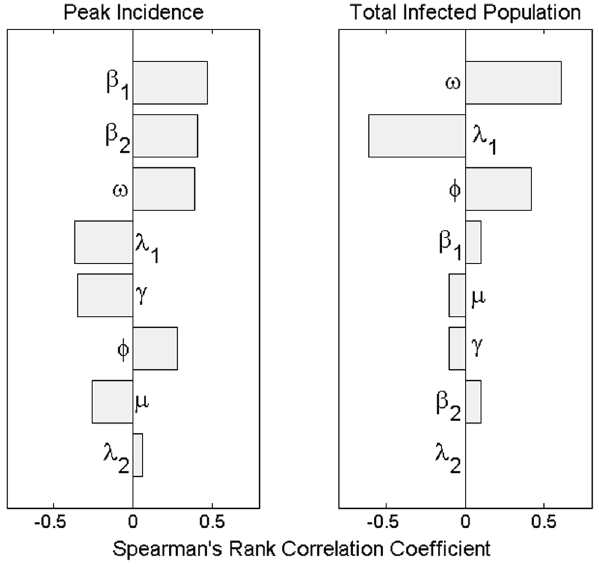
Figure 3. Spearman’s rank correlation coefficients demonstrat- ing model output sensitivity to input parameters. 10,000 iterations of a Monte Carlo simulation were performed allowing each input parameter to vary by 6 10% around its modal value.